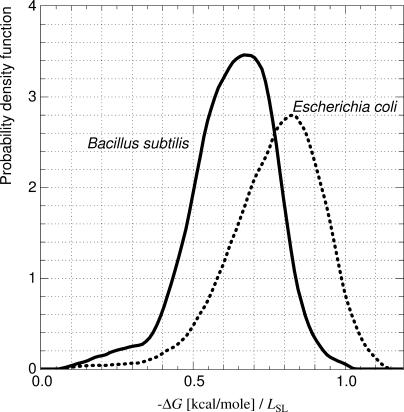
Distribution of Gibbs Free Energy of Stem-Loop Formation, Divided by the Length of the Stem-Loop Structure in NucleotidesThe distribution is calculated from 425 transcriptional terminators in B. subtilis, and 147 previously published Rho-independent terminators in E. coli [16].